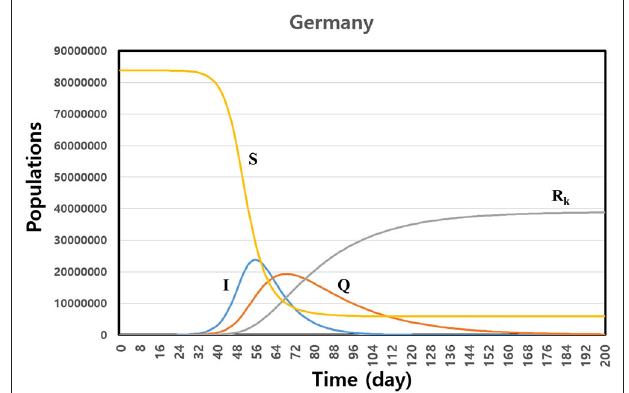
FIGURE 2 | Prediction of the susceptible (S), infecting (I), quarantined (Q), and confirmed accumulated recovered (R k ) individuals based on numerical integration using fitting parameters for Germany. The disease is lasting 200 days after first infecting a